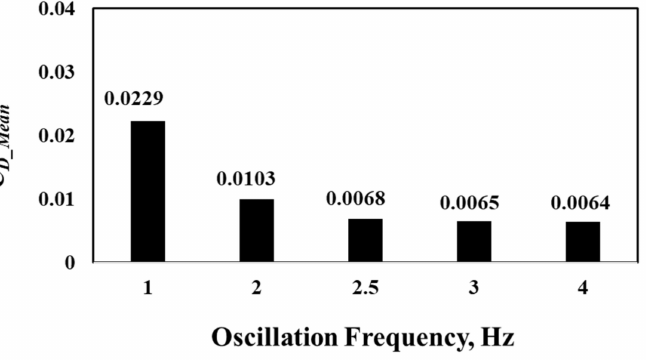
Figure 11. C D _ Mean vs. oscillation frequency for TLC entrained to the side of the obstruction.